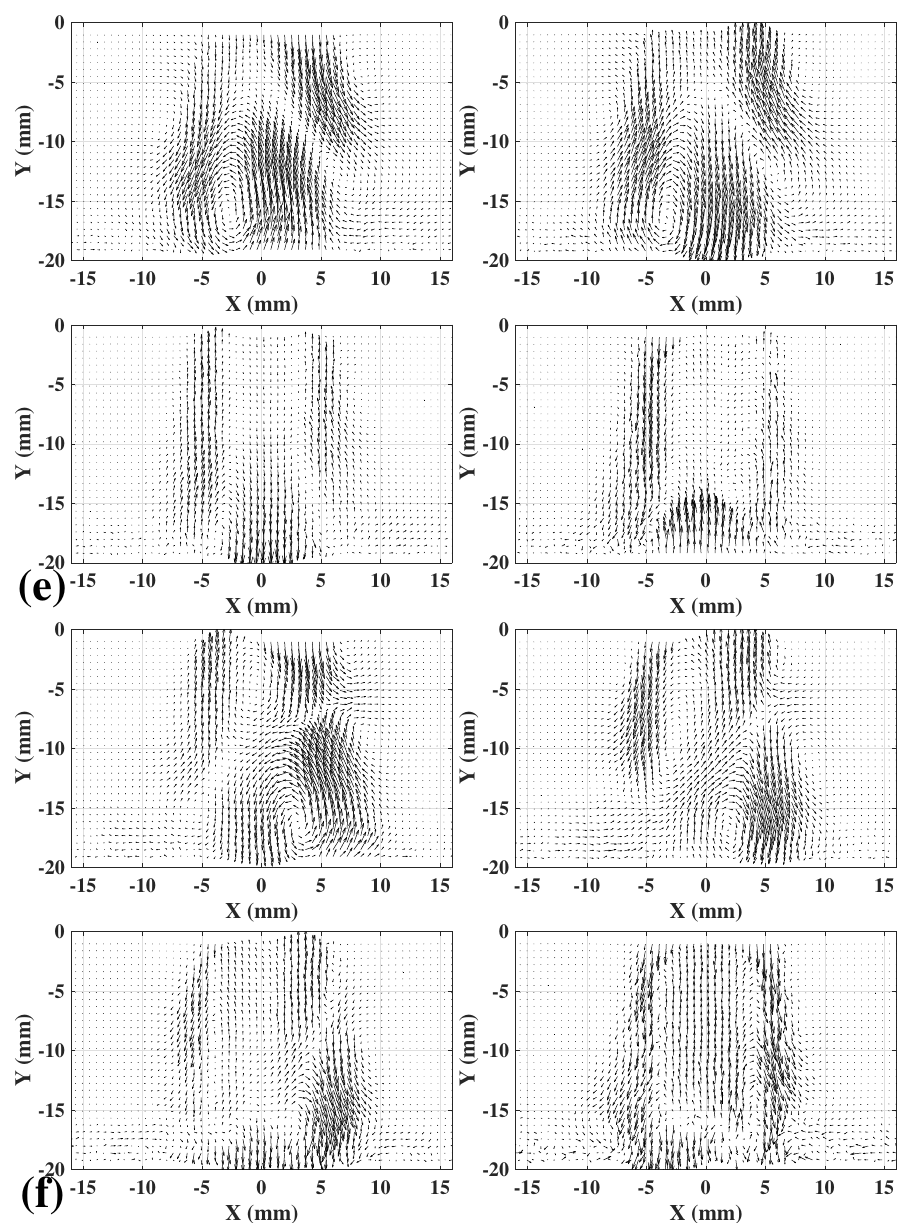
Figure 12. POD analysis of the velocity fields obtained from the 2D2C PIV measurements of impinging jets with e = 20 mm ( e / D j = 1.64) for NPR 1 = 2, NPR 2 = 2.2, NPR 3 = 2.5, and NPR 4 = 2.77. ( a ) Kinetic energy spectra; ( b ) cumulative energy. Low-order POD velocity modes ( c ) Ψ 1 , ( d ) Ψ 2 ; ( e ) Ψ 3 , and ( f ) Ψ 4 . Vectors were de-sampled for better